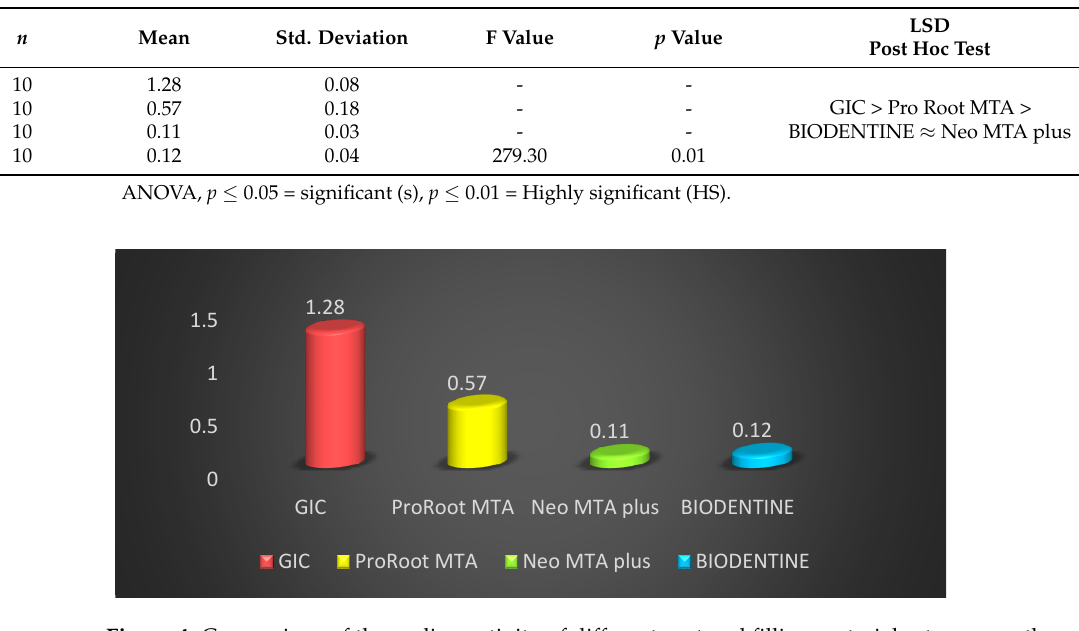
Figure 4. Comparison of the sealing activity of different root end filling materials at one month. The intra group comparison between fifteen days and one month was confirmed with the help of paired t-test. Among the GIC group, the dye penetration at one month was 1.28 ± 0.08 mm, which was not significantly greater than fifteen days (1.20 ± 0.10 mm), with p value = 0.04 (Table 3). The result for ProRoot MTA showed that the dye penetration at one month was 0.57 ± 0.18 mm but it was not significantly greater than fifteen days (0.53 ± 0.16 mm), with p value = 0.67 (Table 3). The intragroup comparison for Neo MTA showed that the dye penetration at one month was 0.11 ± 0.03 mm, which was slightly less compared to fifteen days (0.10 ± 0.03 mm), with p value = 0.91. The intragroup comparison for BIODENTINE showed that the dye penetration at one month (0.12 ± 0.04 mm) which was slightly less as compared to seven days (0.10 ± 0.04 mm), with p value = 0.89 (Table 4) (Figure 5). A box-and-whisker plot was also designed to evaluate whether the results were skewed, and it was observed that the highest and lowest reported microleakage from the GIC group was higher than that seen in the other groups. Also, the lowest median microleakage was seen in the Neo MTA plus group compared to the others. This confirmed the findings from the other tests that there was significant microleakage in the GIC group